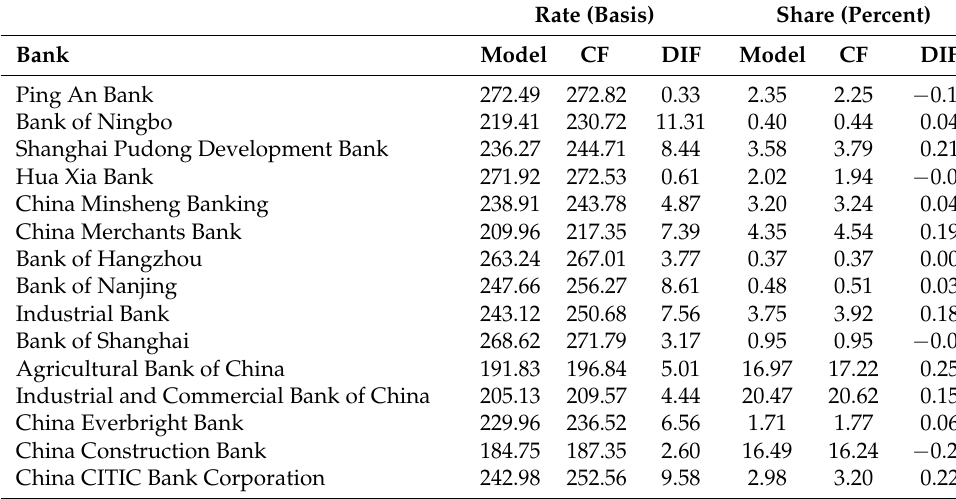
Table 5. Counterfactual Result: Deposit Rate and Deposit Share.